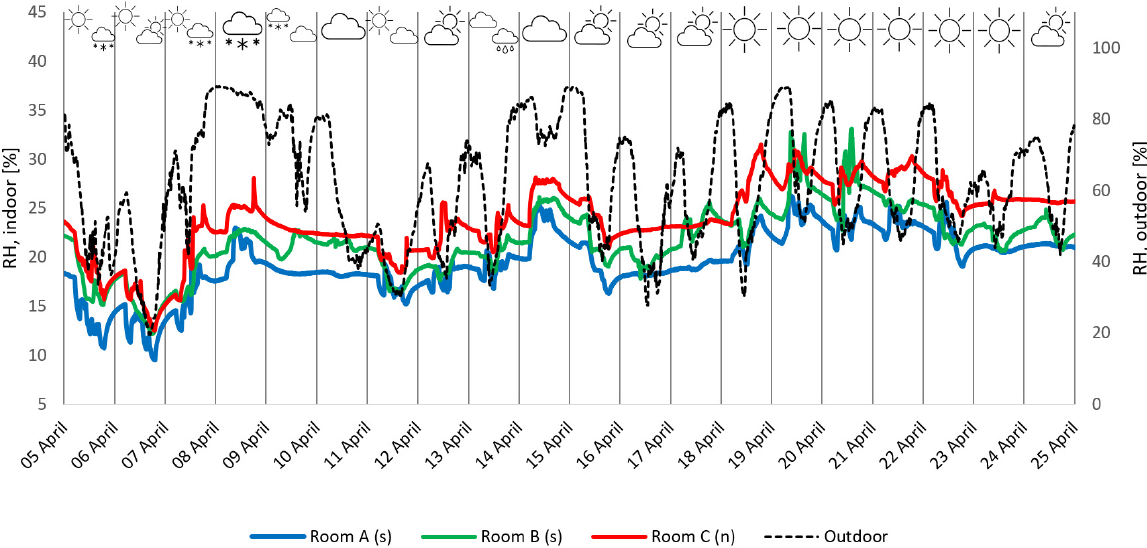
Figure 17. Comparison of indoor and outdoor RH and symbols of weather, with the indoor RH of the three rooms shown on the left axis and the outdoor RH on the right axis.